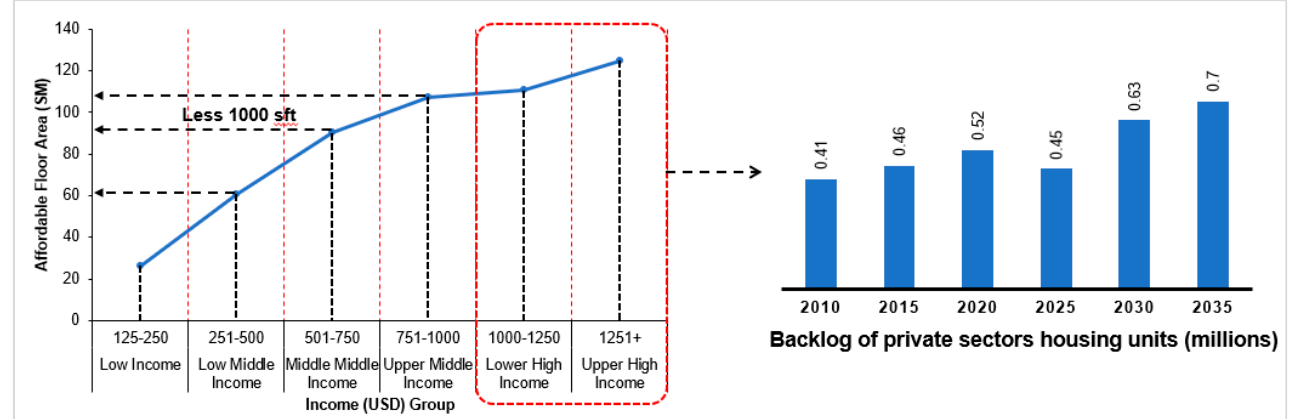
Figure 4. Affordable housing floor area and market supply trend in Dhaka, Bangladesh. Source: [8,9,20,23].